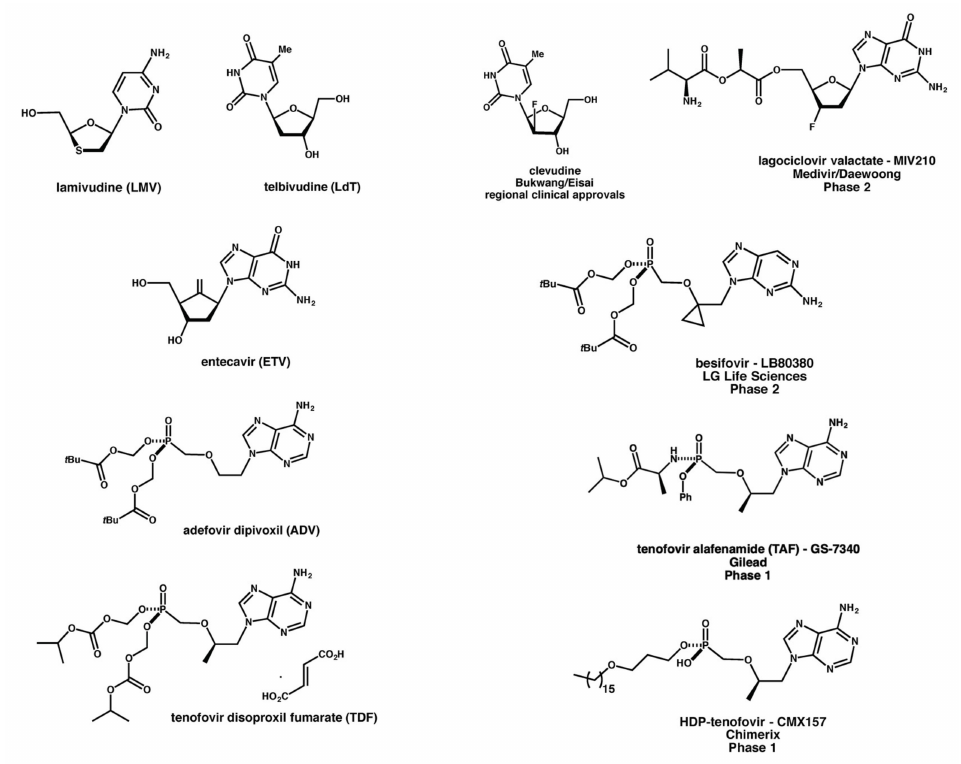
Figure 3. Chemical structures of major clinically approved NUCs. The figure is divided to show NUCs on market (left-hand column), and NUCs in development (right-hand column). Another NUC of note in development is AGX-1009, which is described as a TDF